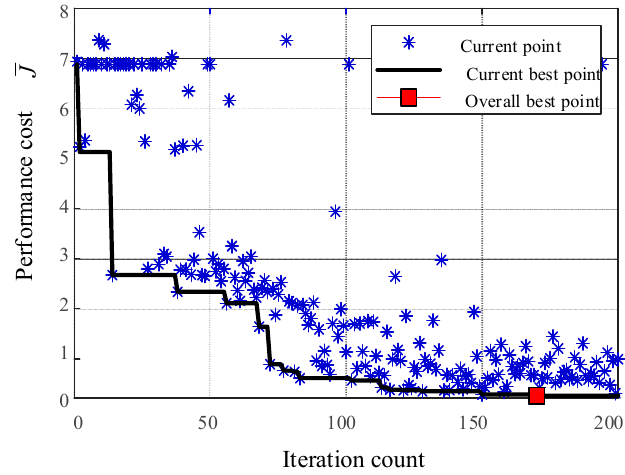
Figure 8. Performance-driven parameter tuning.